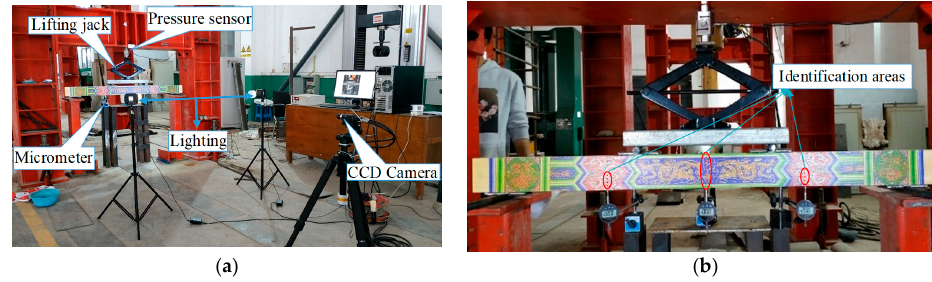
Figure 11. The testing site with panorama: ( a ) experiment setup; ( b ) the test beam.